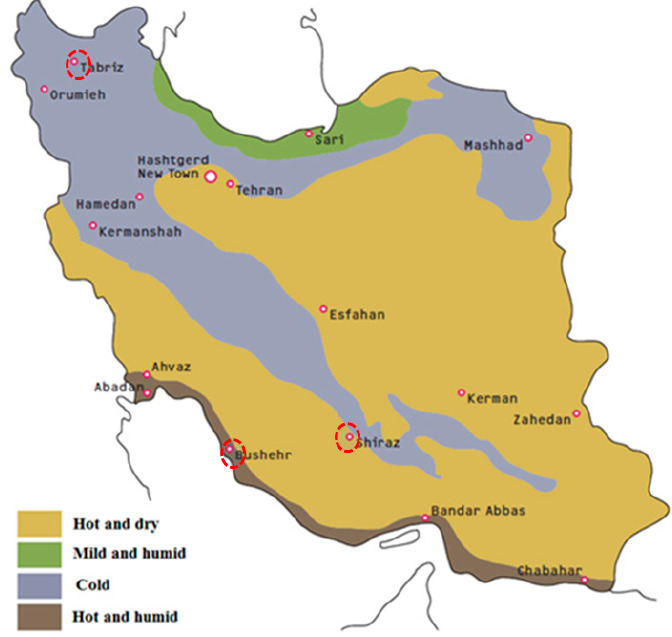
Figure 1. Climatic divisions of Iran [21].